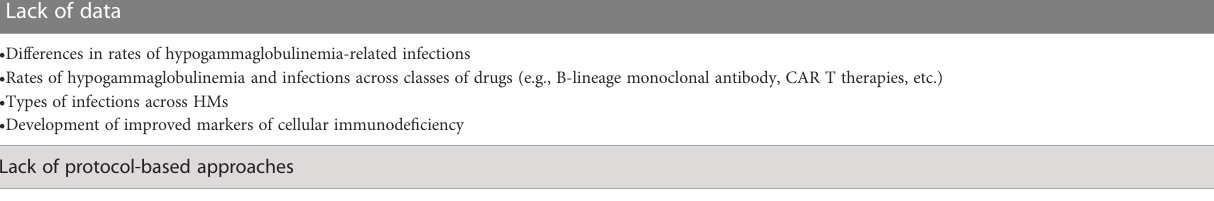
Lack of protocol-based approaches